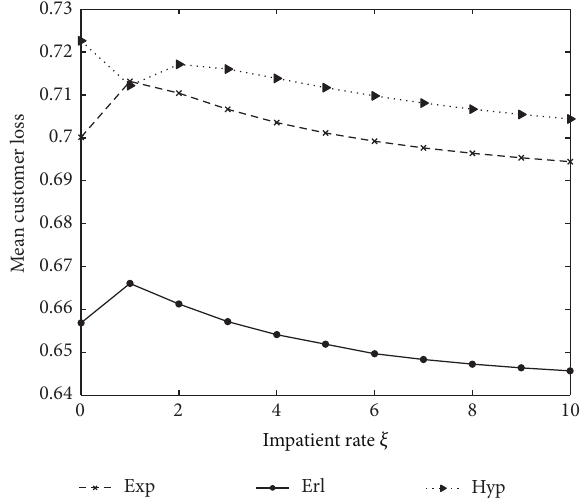
Figure 19: Mean customer loss versus impatient rate with 𝑐 = 3 , = 0.4 , and 𝜃 = 0.1 . 𝜌 = 0.5 , 𝜇 V